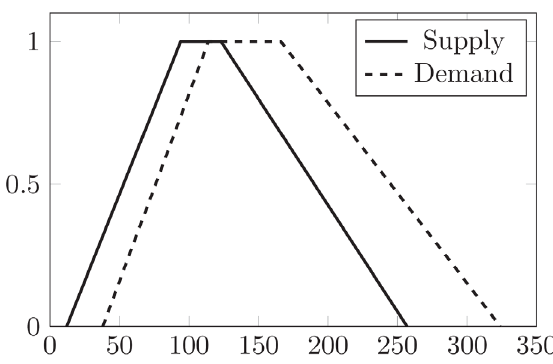
Figure 8. The relationship between supply and demand.